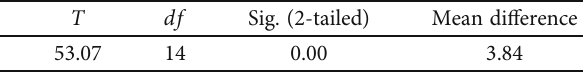
Table 6: One-sample test of the